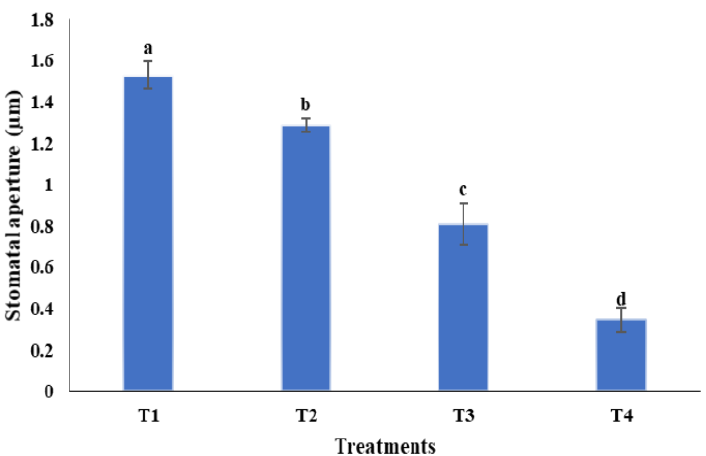
Figure 6. Bar graph showing means and SD of the stomatal aperture of the rice leaves of treatments under gnotobiotic conditions. T 1 —PBS spray; T 2 —PEG6000 (32.6%) + PBS spray; T 3 —PB50 spray inoculation; and T 4 —PEG6000 (32.6%) + PB50 spray inoculation. PBS, phosphate buffer solution. Values with different letters are significantly different according to Duncan’s test ( p ≤